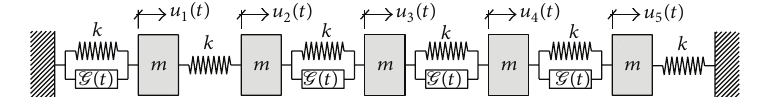
Figure 7: Multiple degrees-of-freedom example: lumped-mass dynamical system with viscoelastic links based on the fractional derivatives.